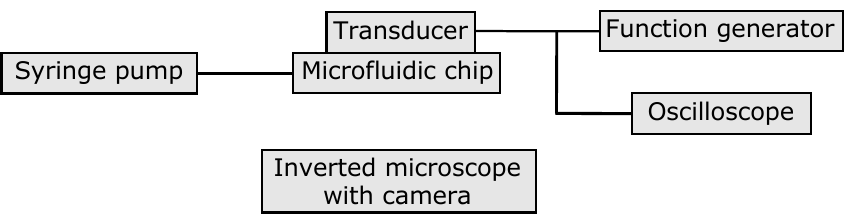
Figure 2. The experimental setup.